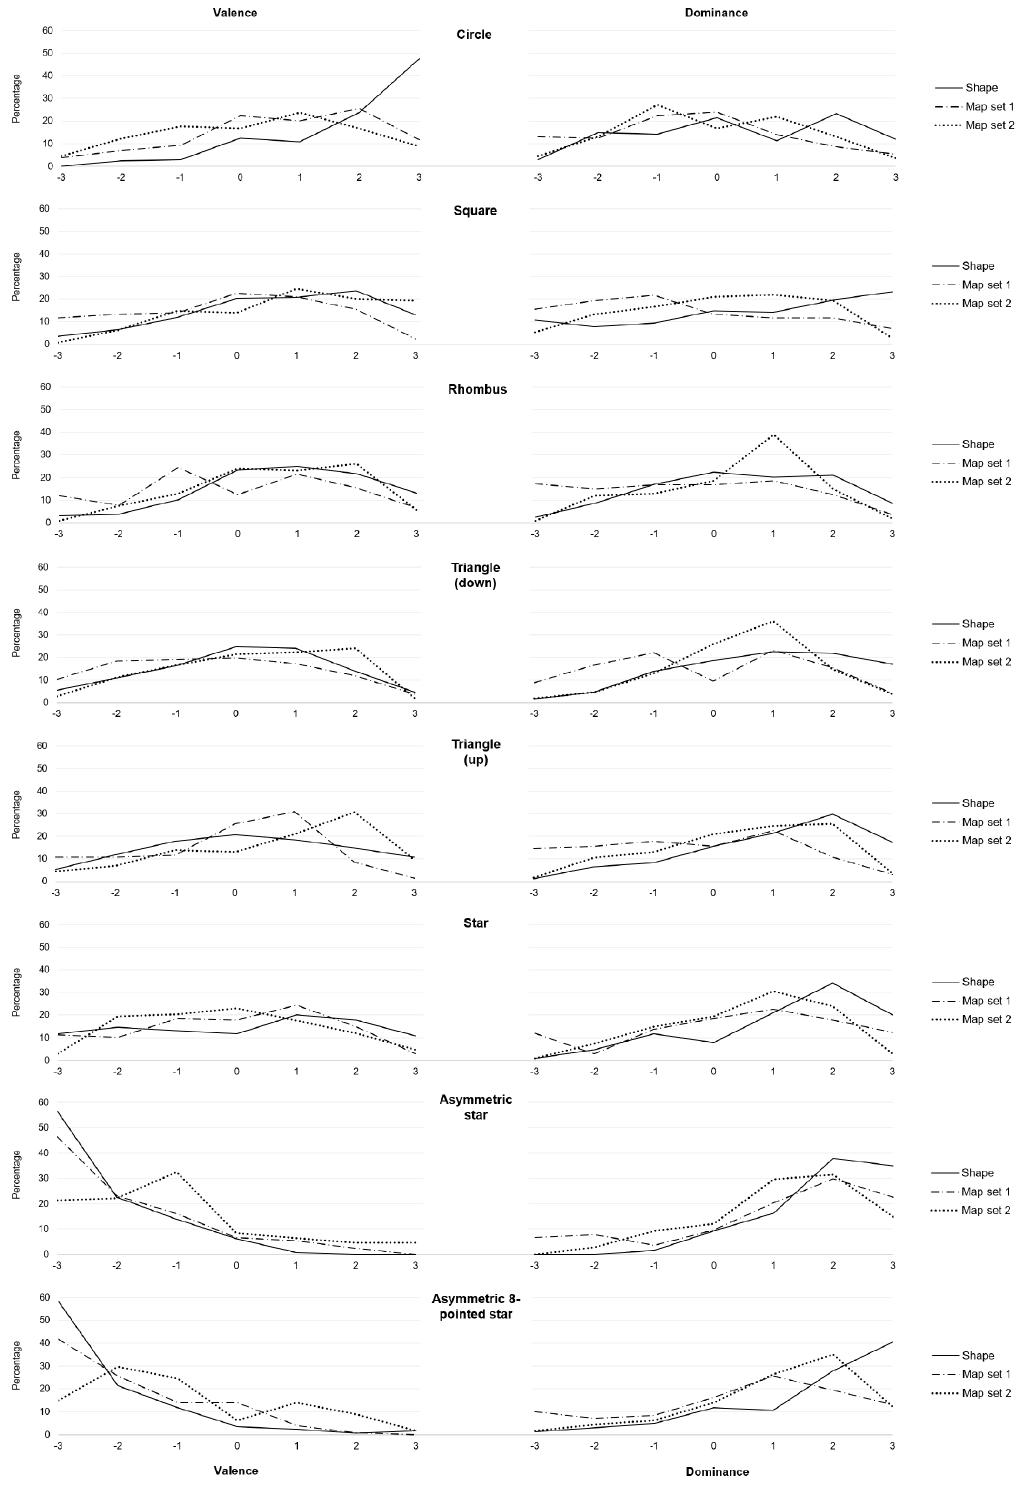
Figure A1. Affective responses towards eight shape stimuli compared between the three stimulus conditions by valence (left) and dominance (right).